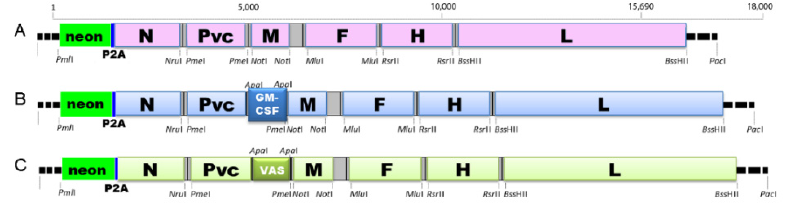
Figure 9. Constructs of the modified viruses: DH82 CDV-Ond neon ( A ), CDV-Ond neon-GM-CSF ( B ) and DH82 CDV-Ond neon-vasostatin ( C